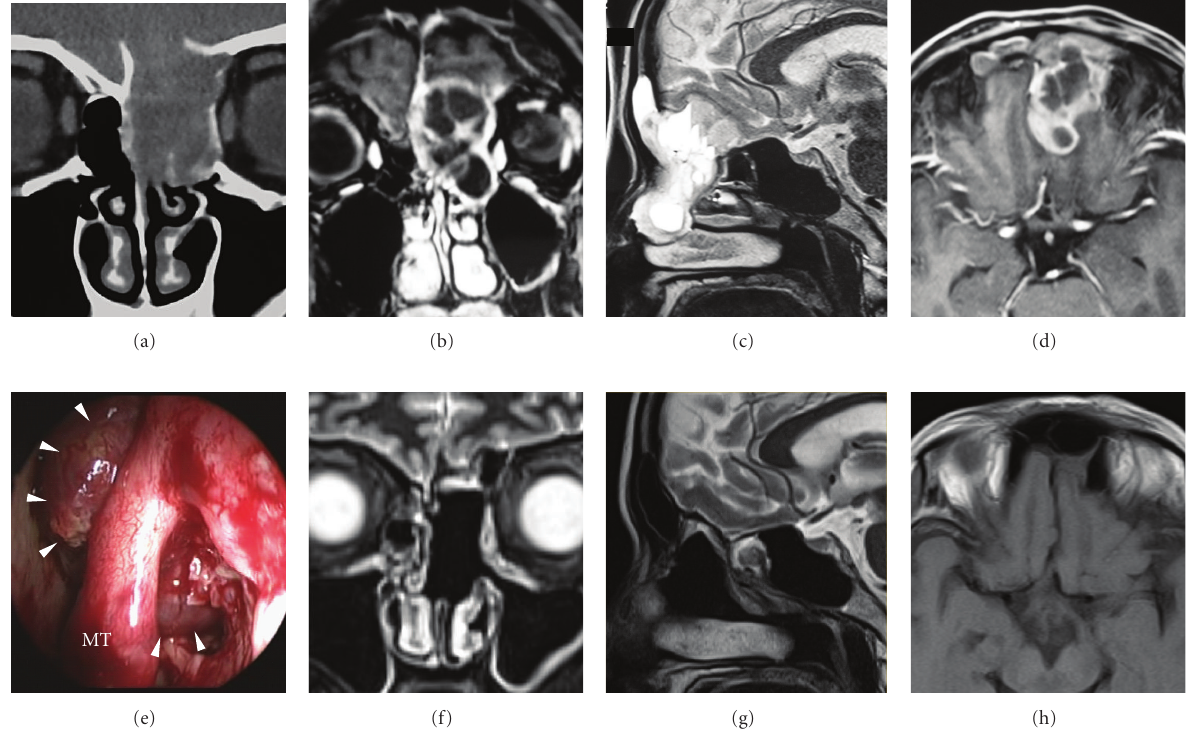
Figure 1: Preoperative computed tomography (a), and magnetic resonance images ((b) coronal, (c) sagittal, and (d) axial) show a cystic mass extending from the left olfactory cleft to the olfactory groove. An endoscopic image (e) shows the tumor extending from the olfactory cleft to the middle meatus (arrowheads). MT: middle turbinate. Magnetic resonance images two years after operation show no recurrence of tumors